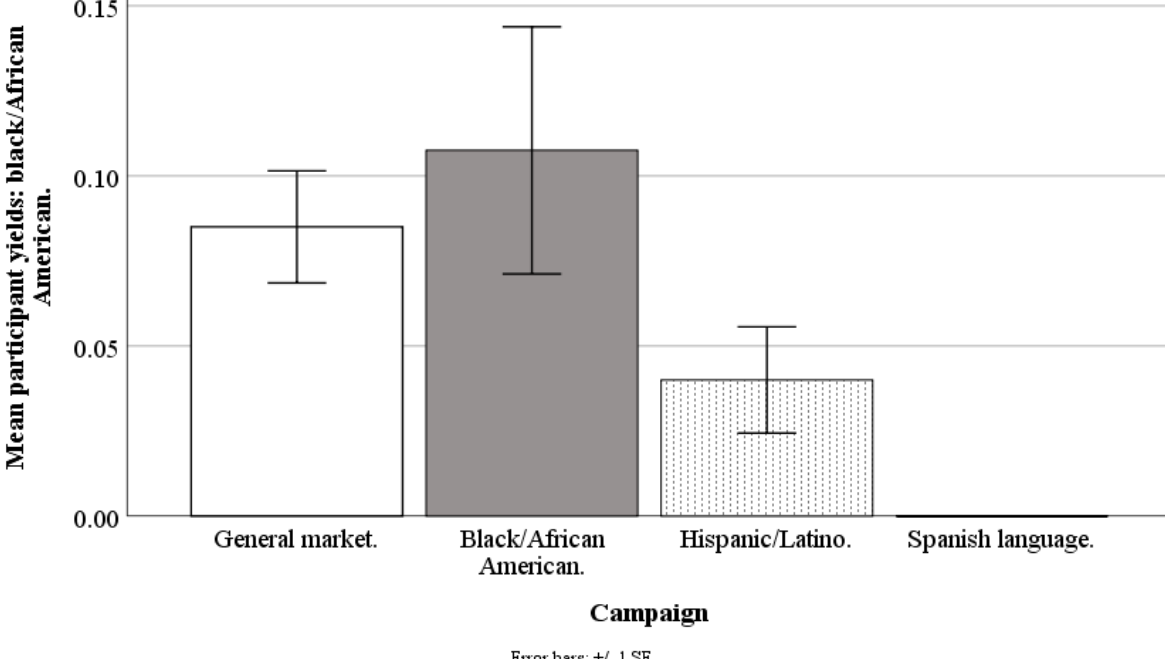
Figure 8. Mean participant yields of blacks/African Americans for Facebook advertising